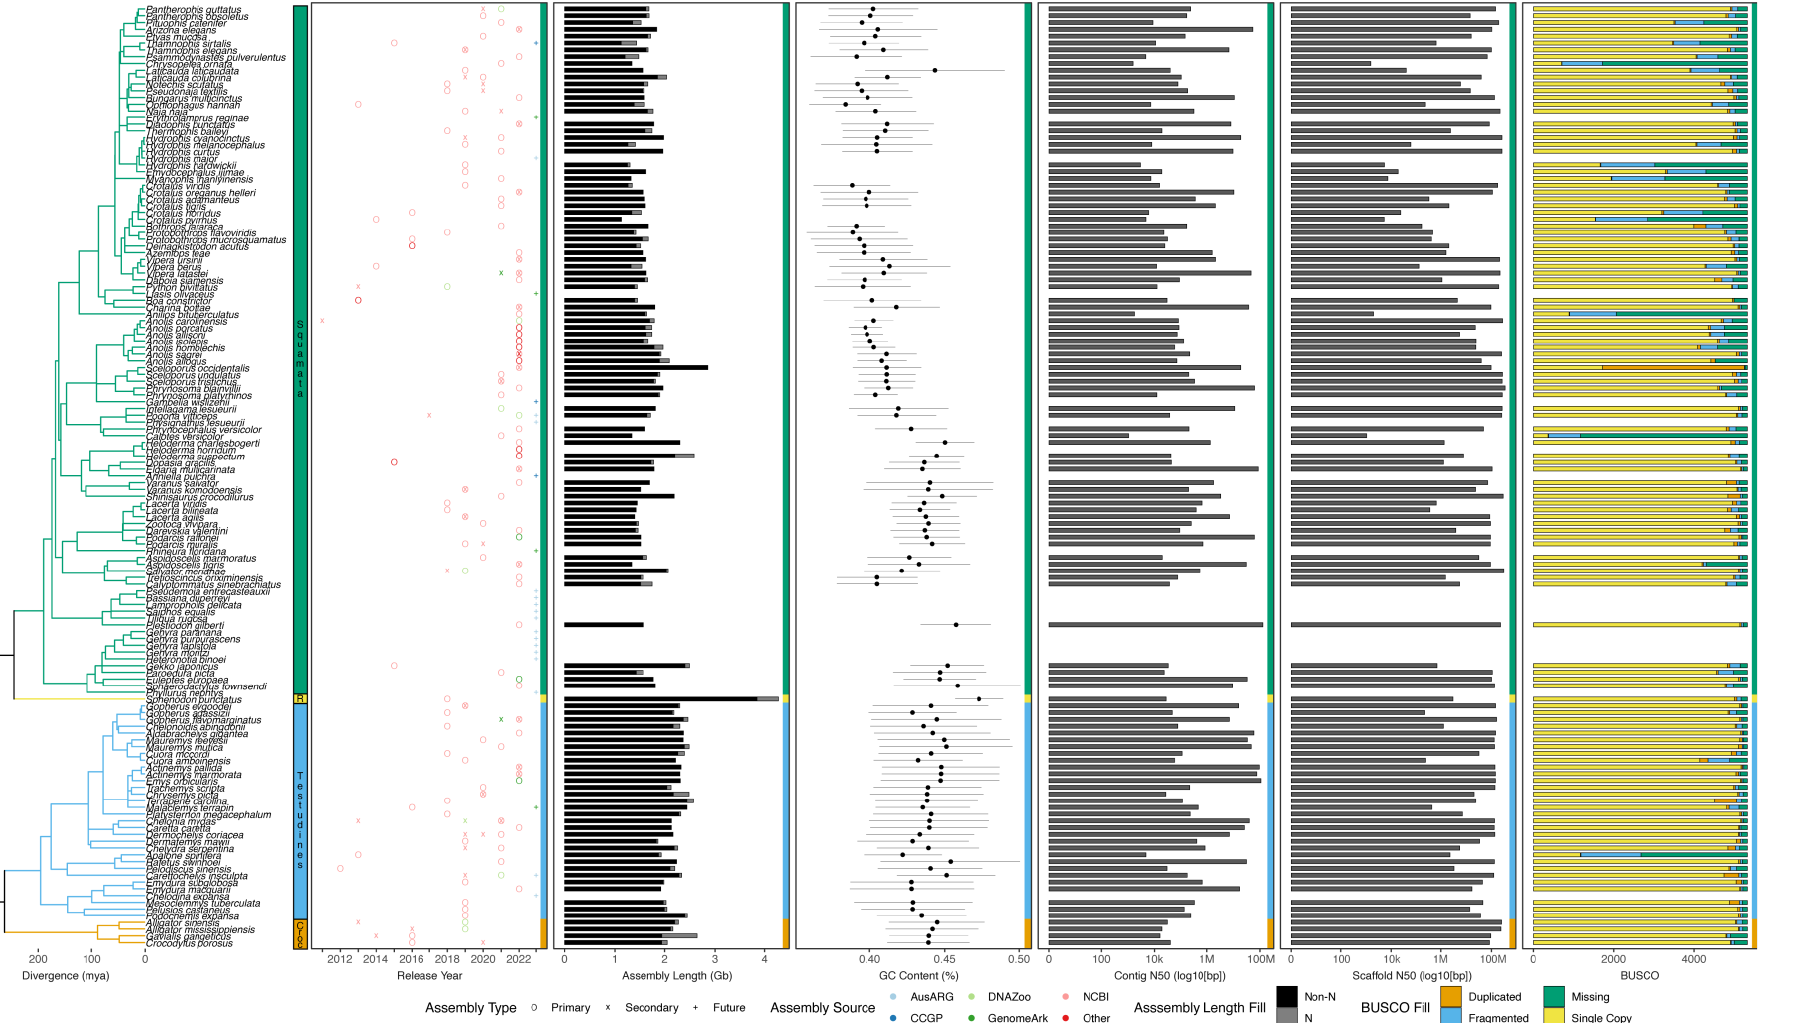
Figure 3. Phylogenetic summary of available reference genomes for non-avian reptiles. The topology and divergence times were gathered from the TimeTree database (accessed 1 December 2022) [4,5]. For taxa that were not already included in TimeTree, we used existing studies of Gehyra [149 – 152], Heloderma [153], Physignathus [154], Gopherus [155,156], Actinemys [157], Cuora [158,159], and Myanophis [160,161] to place taxa and determine the approximate divergence time. Horizontal bars delineate the major clades: Squamata, Rhyncocephalia (“R”), Testudines, and Crocodylia (“Croc”). The colored bars to the right of each panel indicate each clade and aid in visualization. Publicly-available and announced genomes were collated from NCBI, the Genome10K/VGP/EBGP GenomeArk web- site (https://genomeark.github.io/genomeark-all/ (accessed on 1 December 2022)), the DNAZoo website (https://www.dnazoo.org/assemblies (accessed on 1